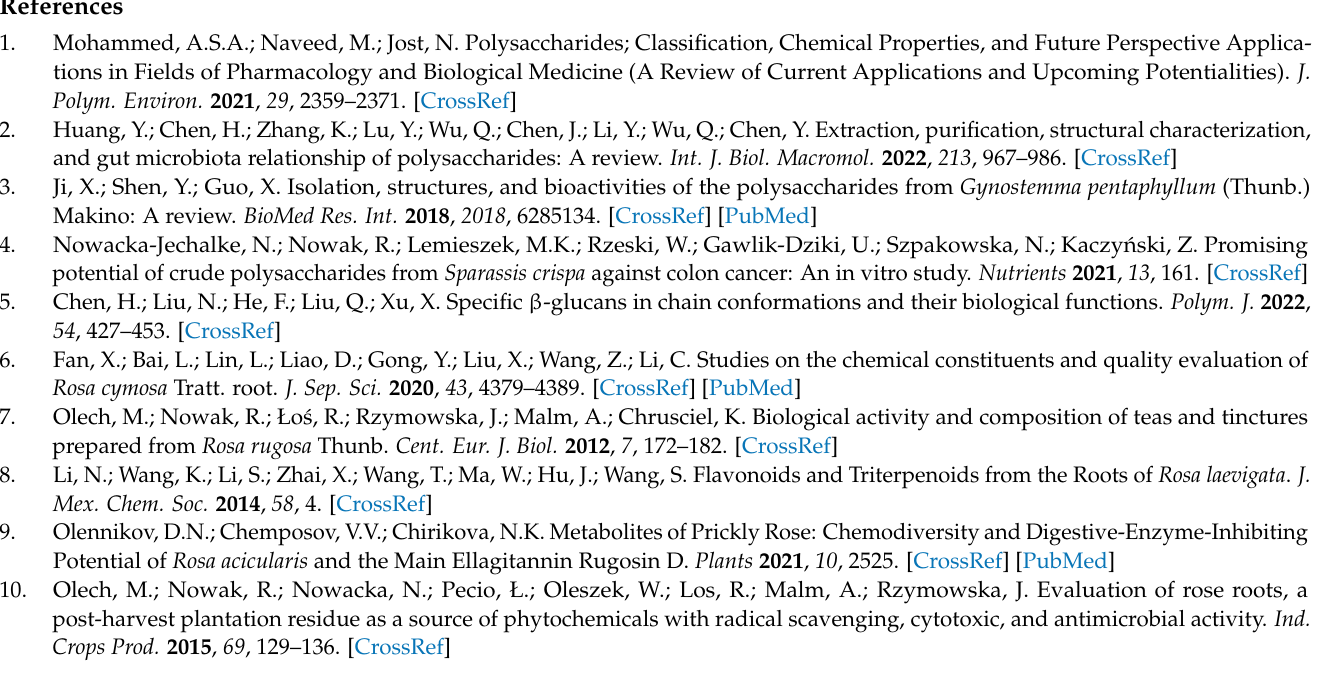
CPL-Rx; Figure S2: Graphical representation of the alignment of Protein Plastid Transcriptionally Active 14 from Rosa chinensis and Arabidopsis thaliana . Figure S3: Morphology of Rosa rugosa